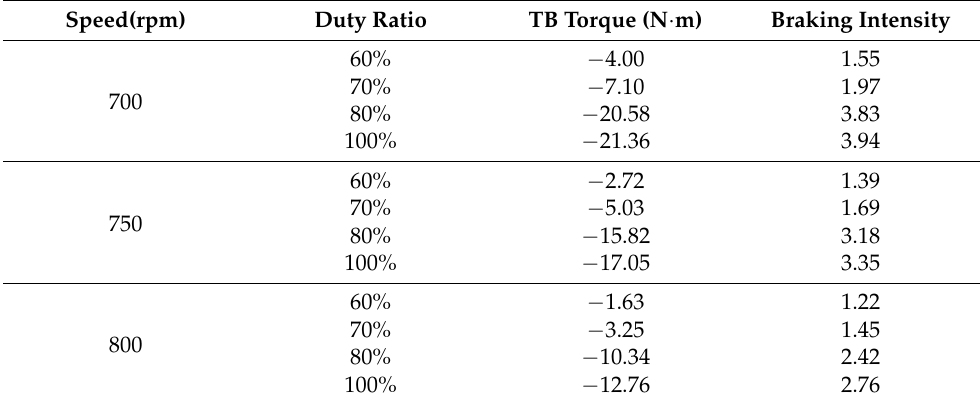
Table 2. TB braking estimations under different duty